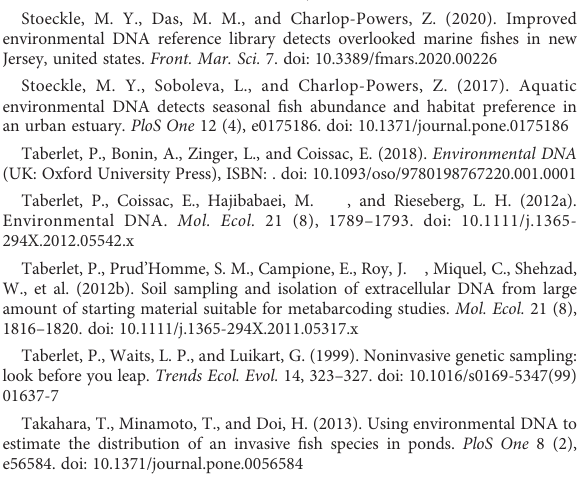
Taberlet, P., Bonin, A., Zinger, L., and Coissac, E. (2018). Environmental DNA (UK: Oxford University Press), ISBN: . doi: 10.1093/oso/9780198767220.001.0001 Taberlet, P., Coissac, E., Hajibabaei, M.